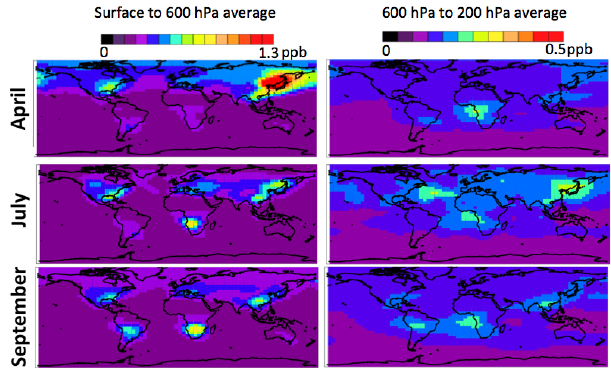
Figure 3. PAN fields from GEOS-Chem. Panels on left show average PAN VMR between 600 hPa and surface for April (top), July (middle) and September (bottom) 2008. Panels on right show averaged VMR between 600 and 200 hPa.